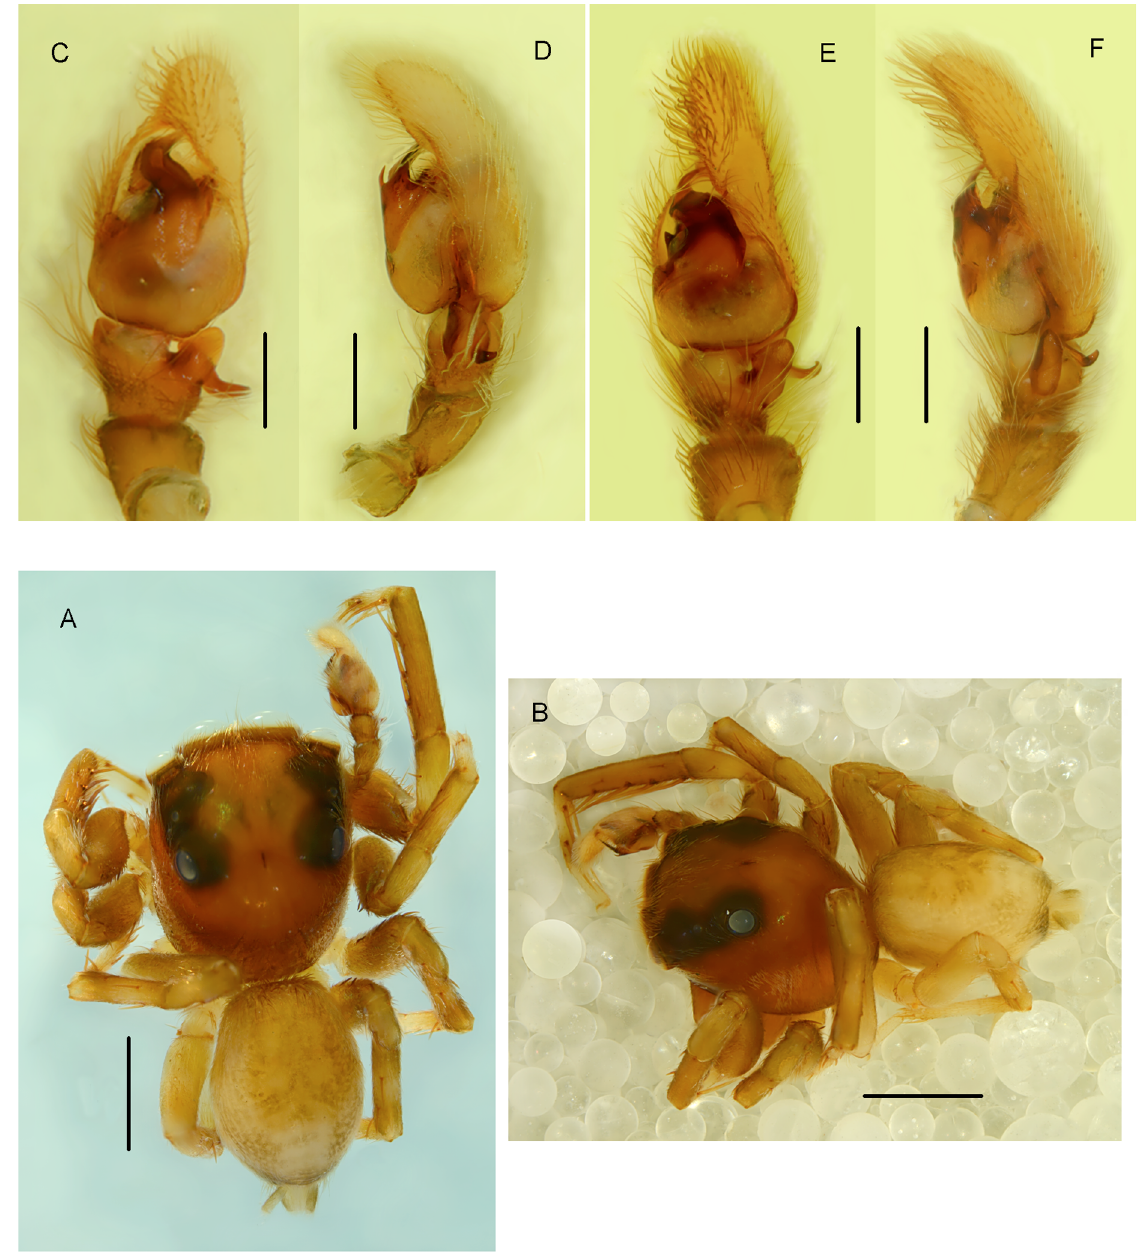
Fig. 14. Pochytoides spiniger sp. nov., paratypes, ♂ (e–F specimen from Nion). A–B . General appearance. A . Dorsal view. B . Dorsolateral view. C–F . Palpal organ. C . Ventral view. D , F . Retrolateral view. E . Ventroretrolateral view. scale bars: A–B = 1.0 mm, C–F = 0.3